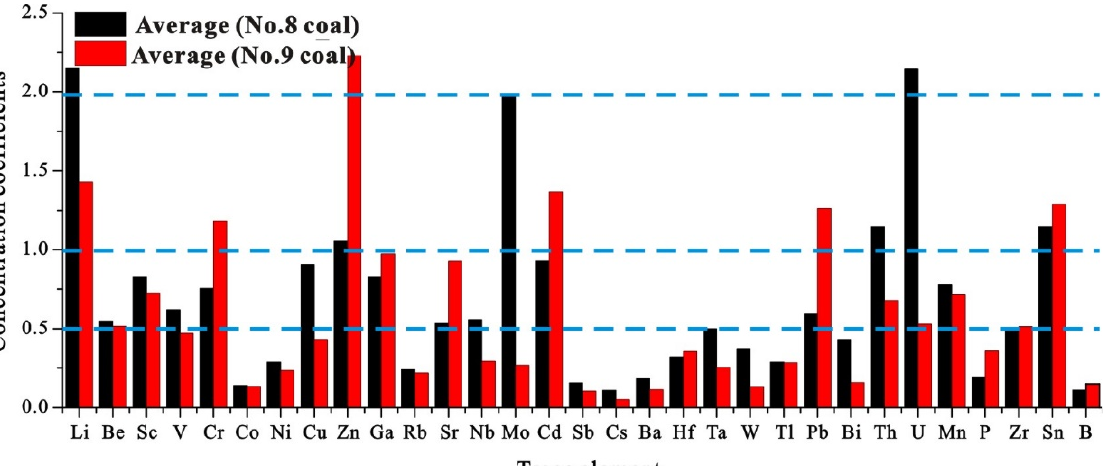
Figure 6. Average enrichment coefficient of trace elements in a coal sample. Table 5. Trace elements content in coal samples (µg/g).